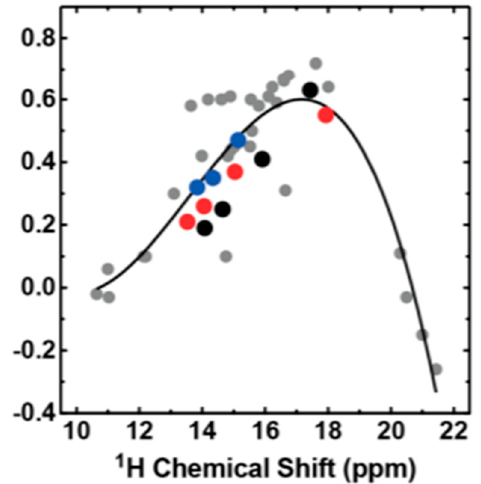
Figure 25. Plot primary deuterium isotope effects for a series of salicylates: 5-methylsalicylate, 4- methoxysalicylate, 5-formylsalicylate and 3,5-dinitrosalicylate. Chloroform (red), acetone (black) and water (blue) and for previously published O − H···O − hydrogen-bonded complexes in aprotic organic solvents (gray) [64] vs. OH chemical shifts. Reprinted with permission from Ref. [42]. Copyright 2015 American Chemical Society.